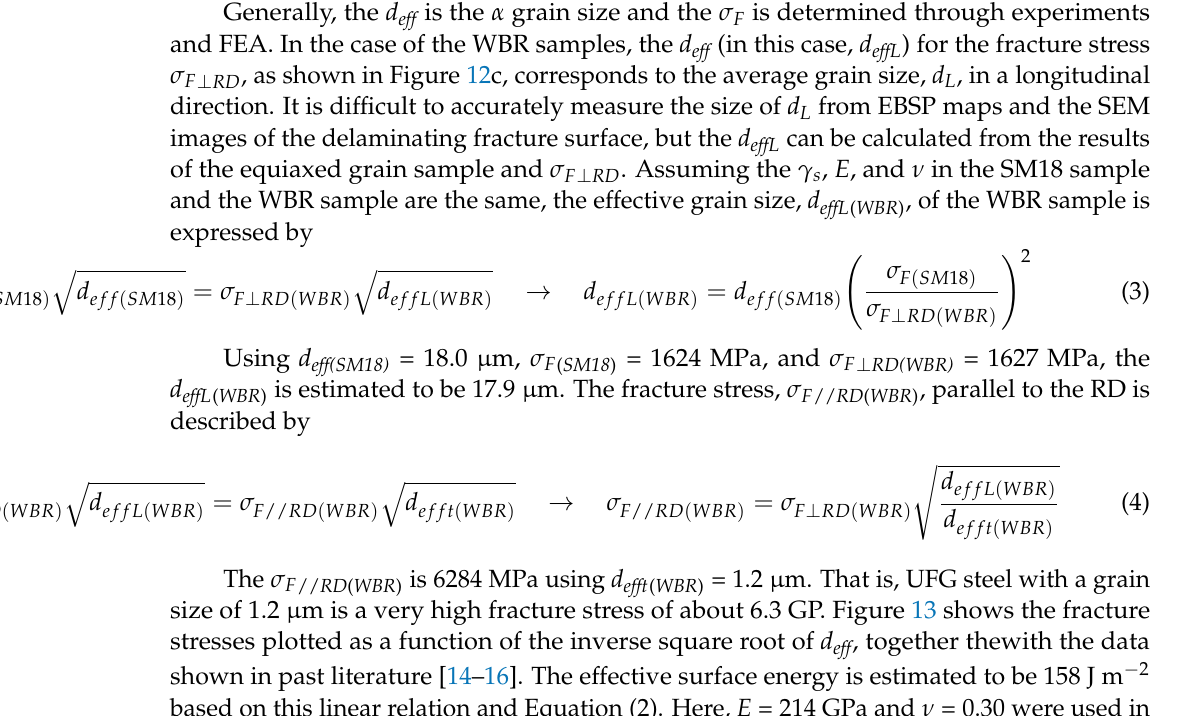
this relation [21]. This value is included in the ranges of 90–190 J m − 2 for C-Mn steels with α -pearlite microstructure [26].